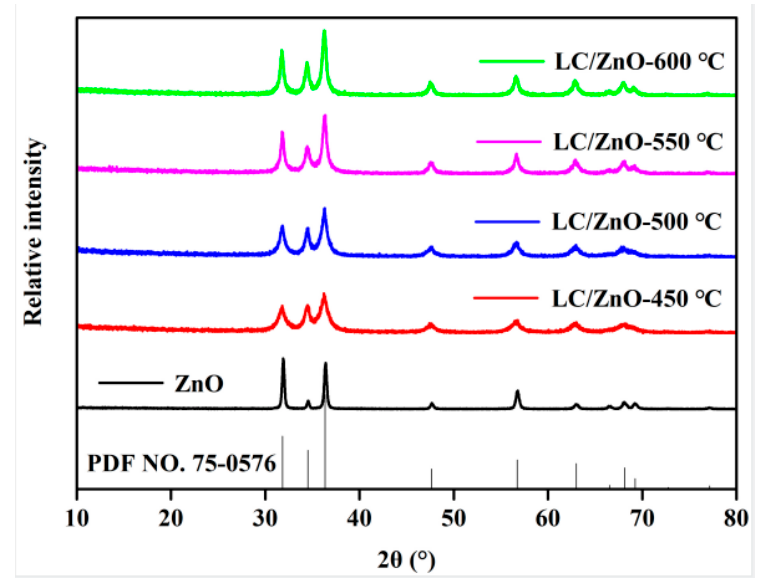
Figure 1. XRD patterns of LC/ZnO